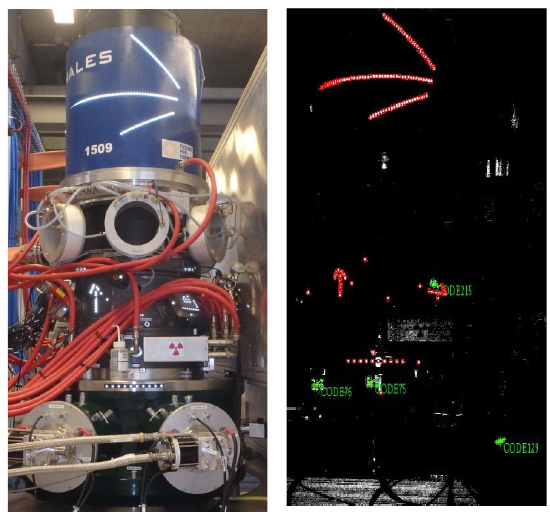
Fig. 7. Normal picture and photogrammetry image obtained in the different targets installed in the EU gyrotron prototype .